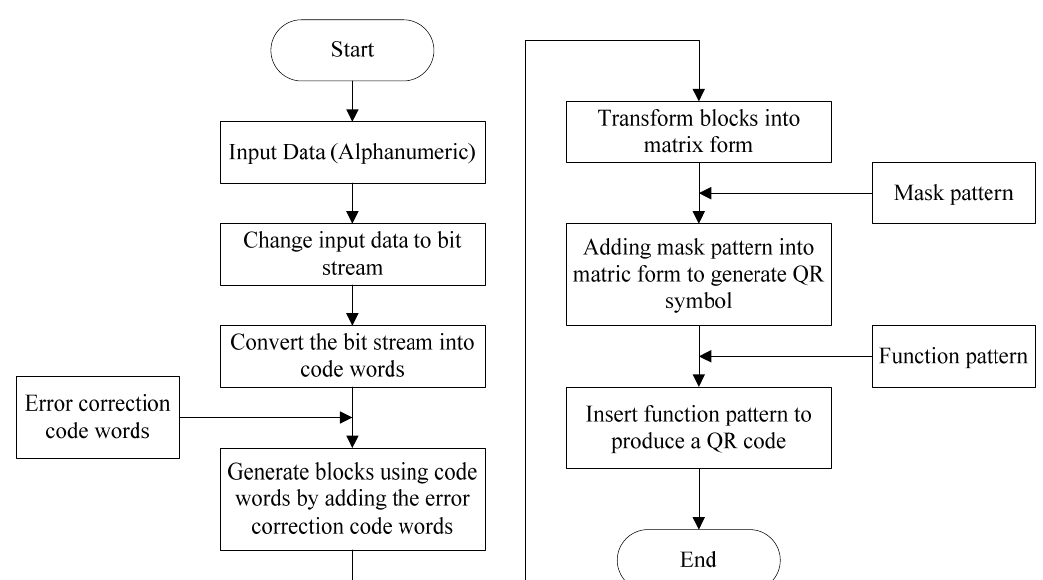
Figure 11. Data encoding